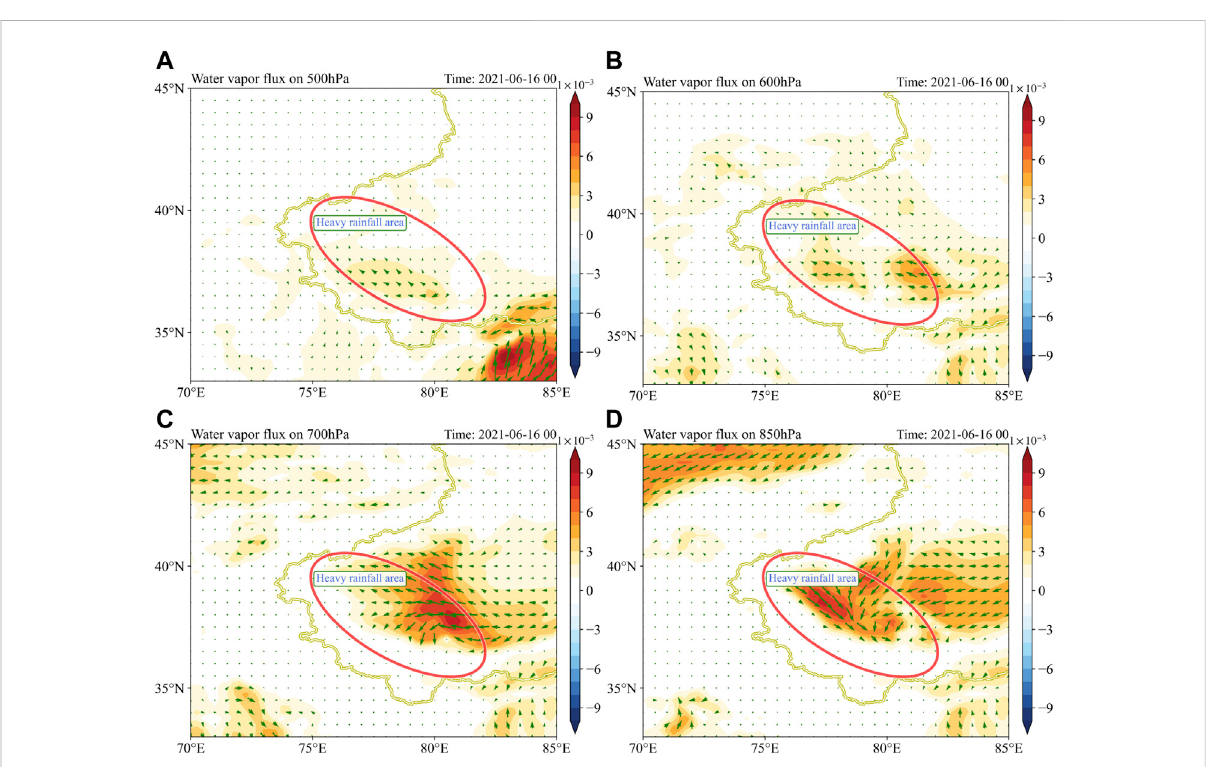
FIGURE 14 Water vapor fl ux on 500 hPa (A) , 600 hPa (B) , 700 hPa (C) and 850 hPa (D) pressure level at 00:00 16 June 2021